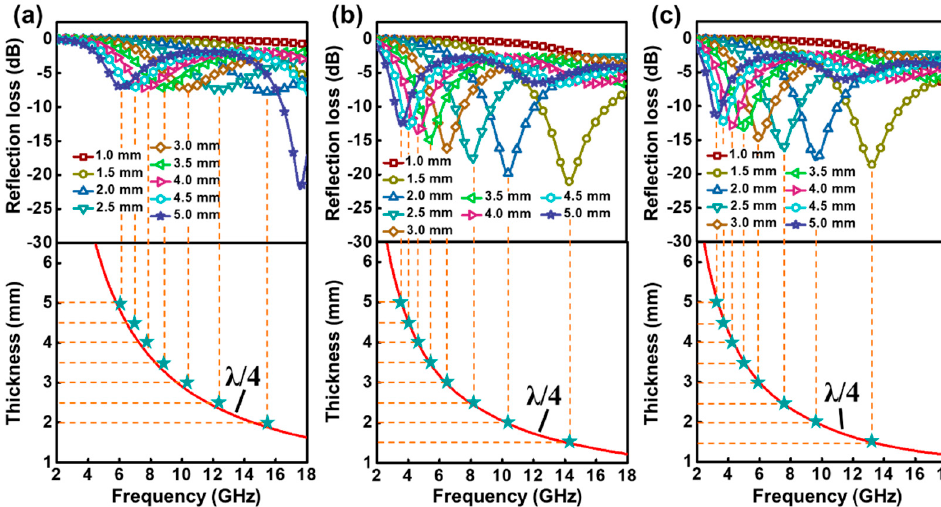
Figure 5. The relationship between the minimum RL values with different thicknesses of DS − Mo 2 C/C − 700 ( a ), DS − Mo 2 C/C − 800 ( b ), and DS − Mo 2 C/C − 900 ( c ).